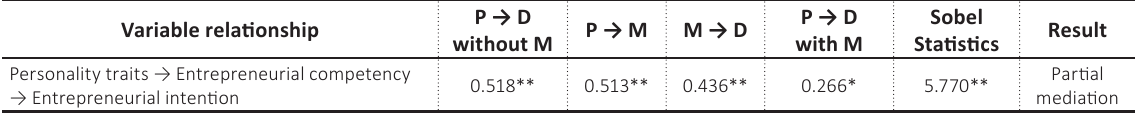
Table 7. Mediation analysis Variable relationship Personality traits → Entrepreneurial competency → Entrepreneurial